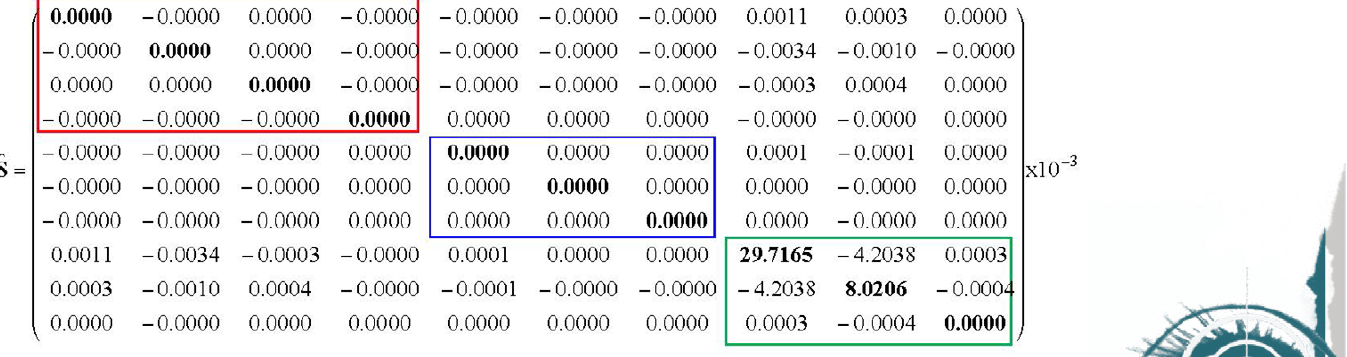
) T Table 3. The sample variance-covariance matrix ˆ S for the coordinate vectors ( N =43) for the cornea of Subject 1 is indicated. Units have been omitted to save space. They are metres for ˆ B (see blue block), dioptres for ˆ C (green block) and ˆ A is unit-less (red block). The matrix is symmetric so we are interested only in the 10 variances (in bold, top left to bottom right) and the 45 covari- ances (for example, below the diagonal). Most of the covariances are almost zero. The entries in the red block are the variances and covariances of ˆ S while those in the blue and green blocks are for ˆ S and ˆ S respectively. Each of the entries of ˆ S has been ˆ A ˆ B ˆ C pre-multiplied by 103 and hence the 10-3 that follows the matrix